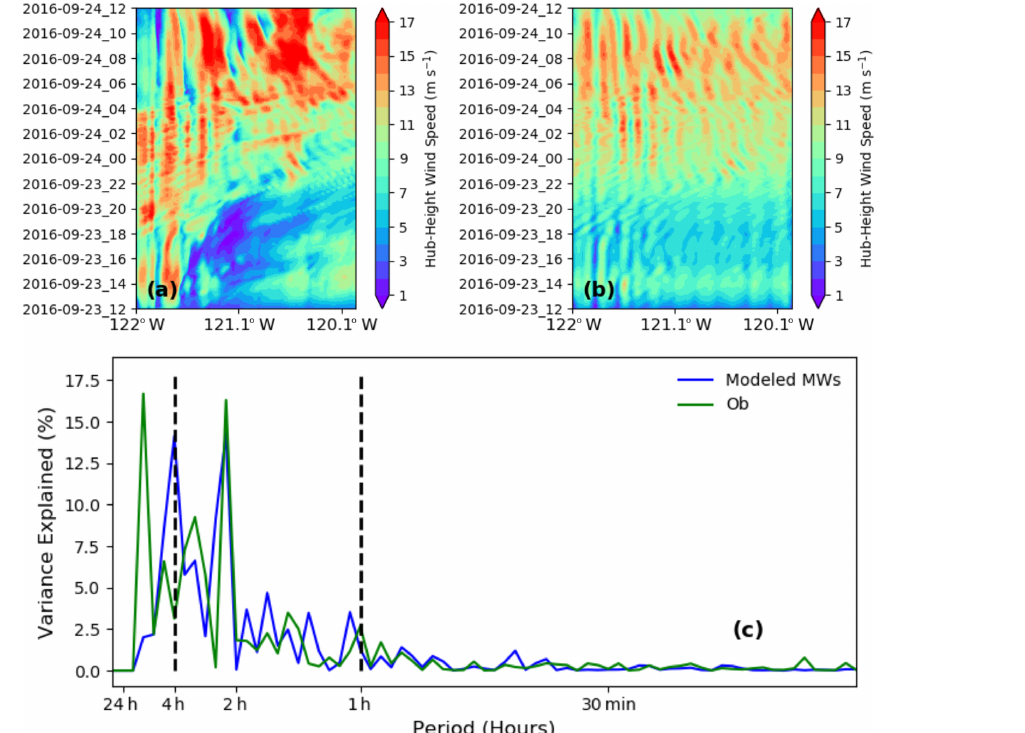
Figure 10. (a) Hovmöller diagram of simulated hub-height wind speeds at the targeted latitude. (b) Same as (a) but showing the filtered wind speeds with wavelengths from 8 to 18km. (c) Observed (green) and reconstructed (blue) power spectrum on the time domain for 24 September 2016. The simulated FFT was reconstructed with wavelengths from 8 to 18km. The dashed lines indicate the wave period of interest from 1 to 4h. Please note that the date format in this figure is year month day